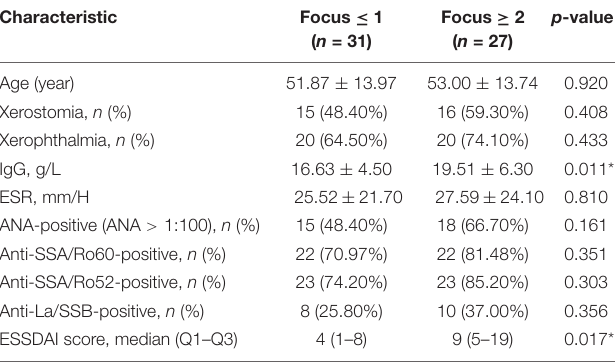
TABLE 2 | Clinical information of 58 primary Sjögren’s syndrome patients.